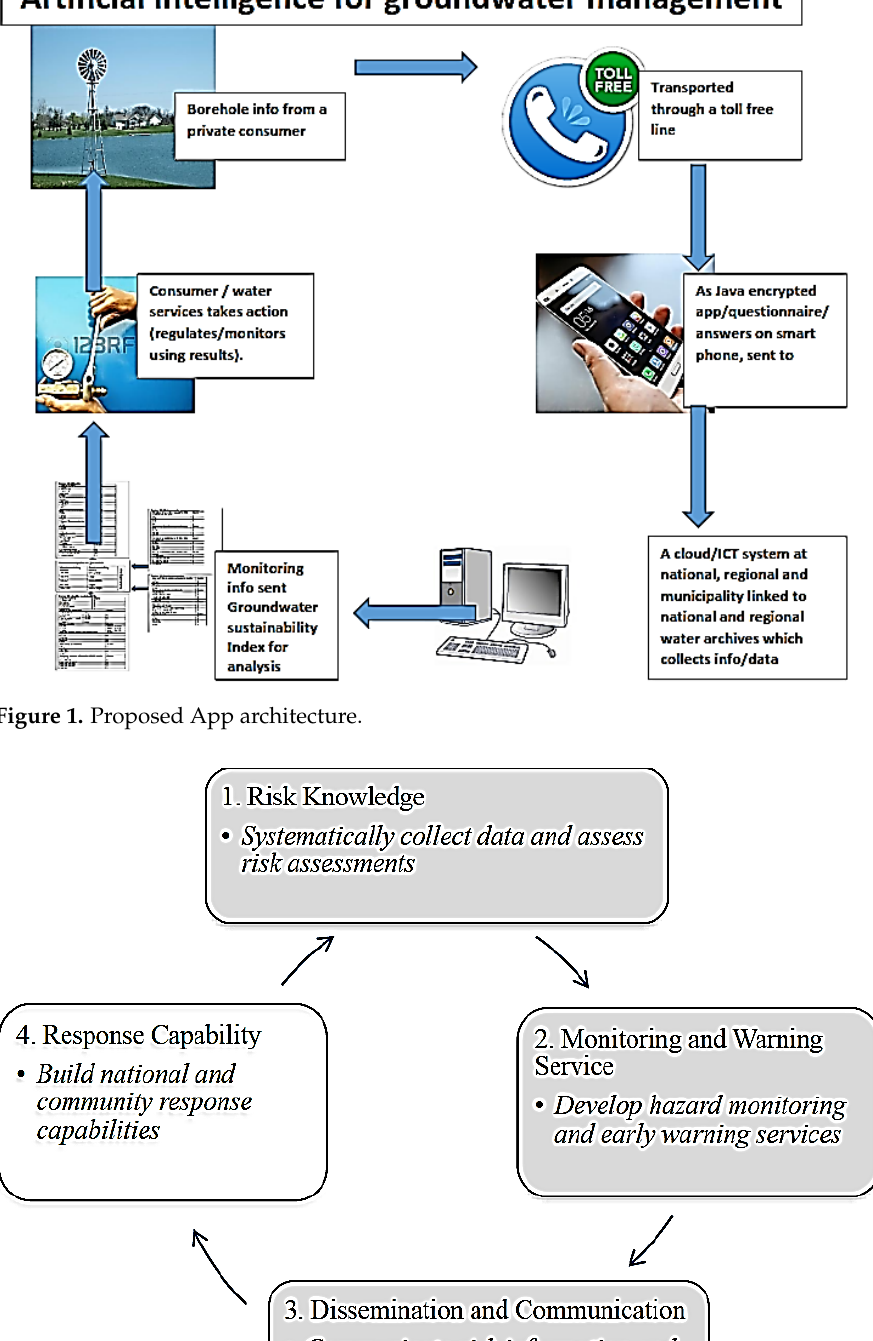
Figure 1. Proposed App architecture.